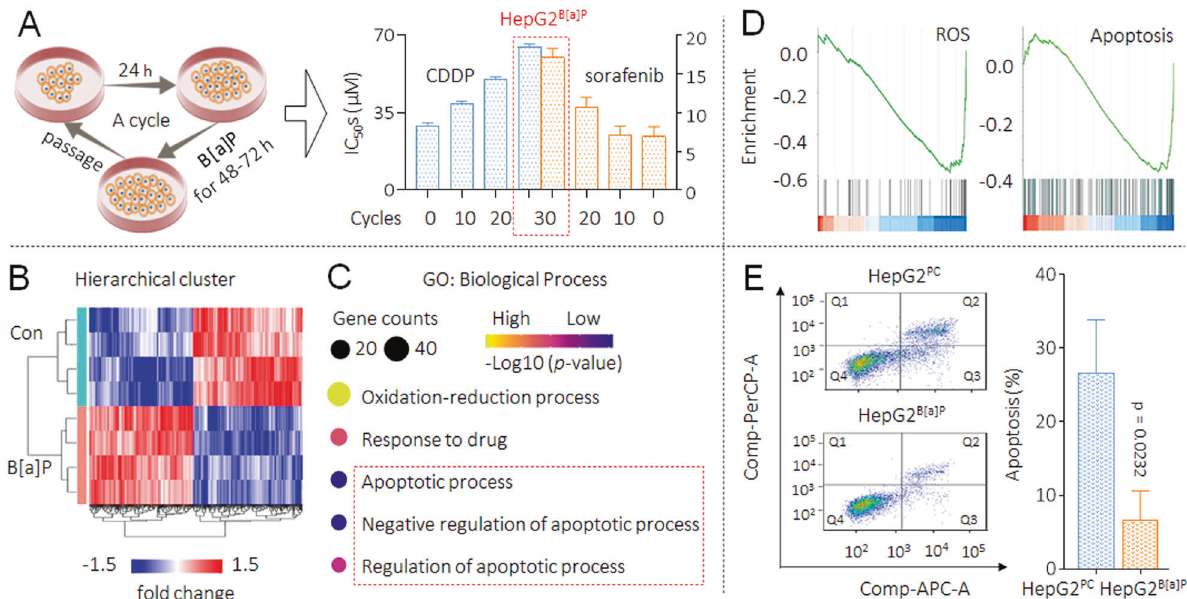
Fig. 1 MDR caused by B[a]P, and the key biological process involved. A , left The fl ow chart for the establishment of B[a]P-induced MDR cell model in HepG2 cells. A , right The cell viabilities were determined in triplicate, and the IC 50 s were calculated. B A heat-map of the DEGs with p < 0.05 and |logFC | > 0.5 in GSE36244 dataset. C GO biological process enrichment analysis of DEGs. D Enrichment plots from GSEA showing the enrichments of ROS and apoptosis-related genes in the DEGs group. E Flow cytometric analyses of the percentage of cells in